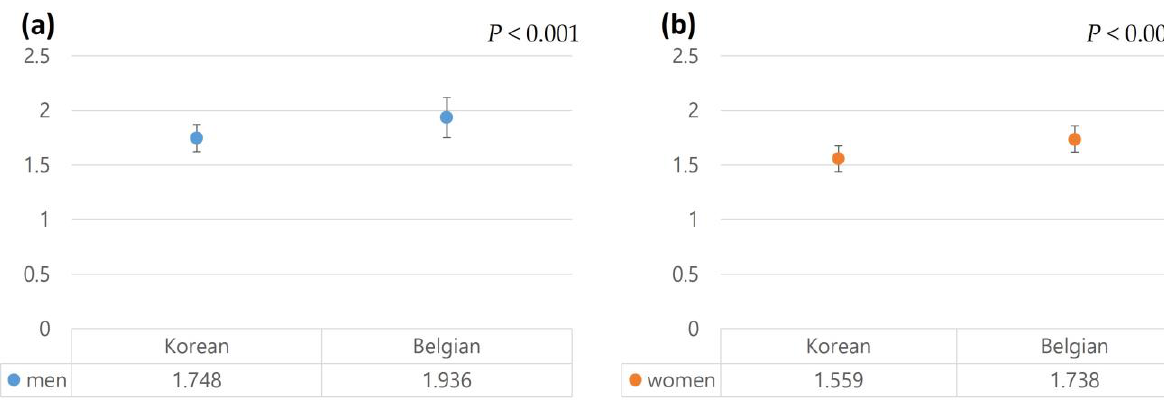
Figure 5. Body surface area of Korean and Belgian cohort: ( a ), Men; ( b ), Women. blue, men; orange, women.